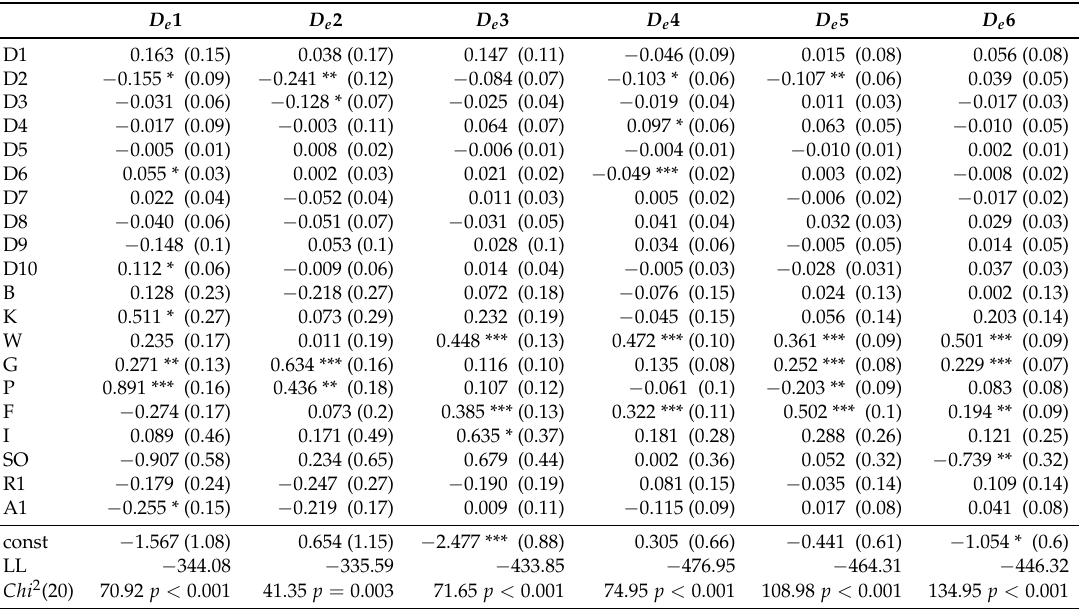
Table 5. Estimation results for tobit model (N =